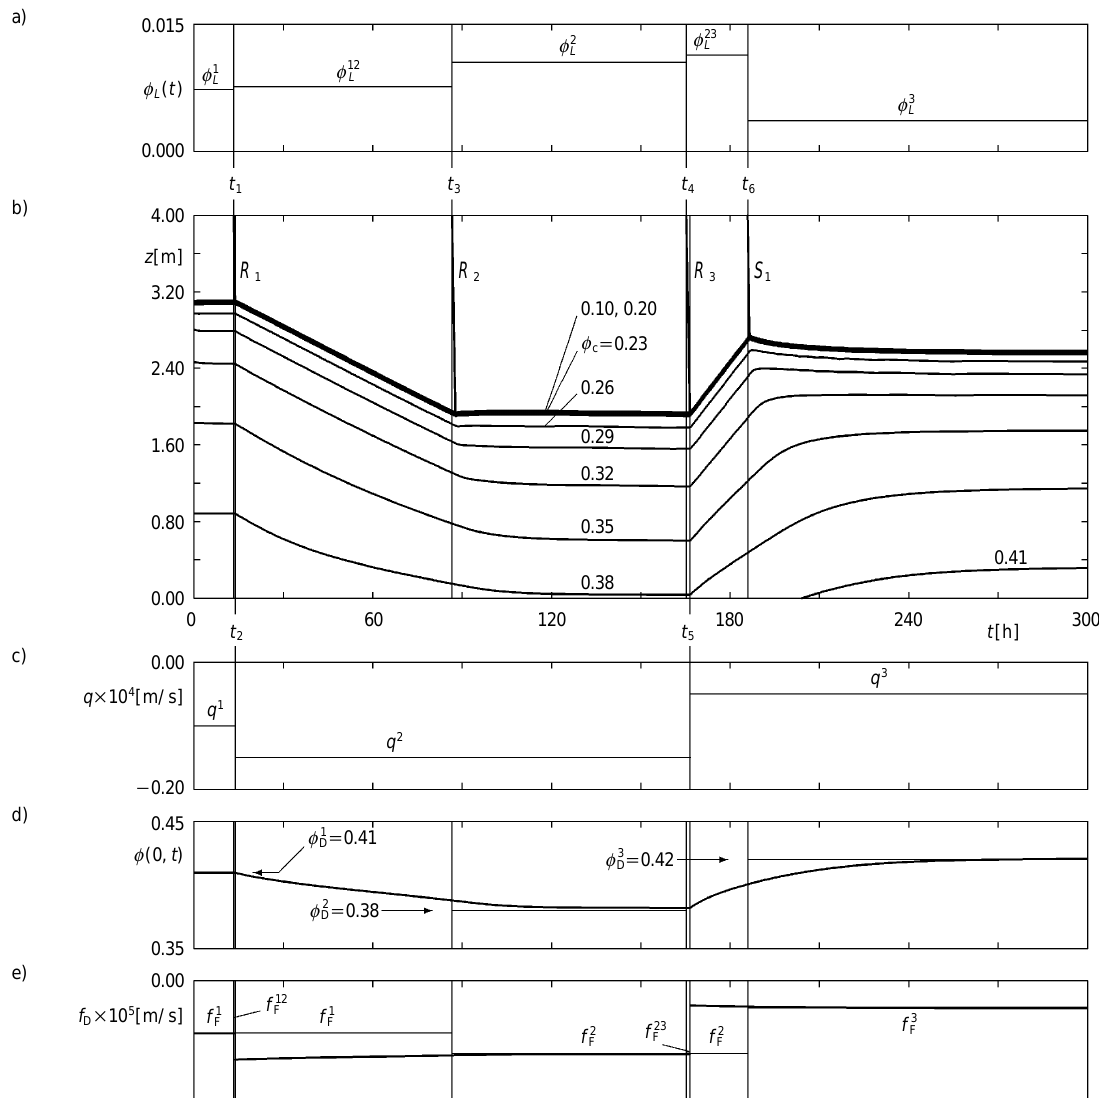
Simulation of transitions between three steady states in an ICT: a) prescribed values of f L , b) settling plot (the iso-concentration lines correspond to the annotated values), c) prescribed values of q ( t ), d) the numerically calculated discharge concentration, together with the discharge concentrations of the target steady states, e) the numerically computed solids discharge flux, compared with prescribed values of the